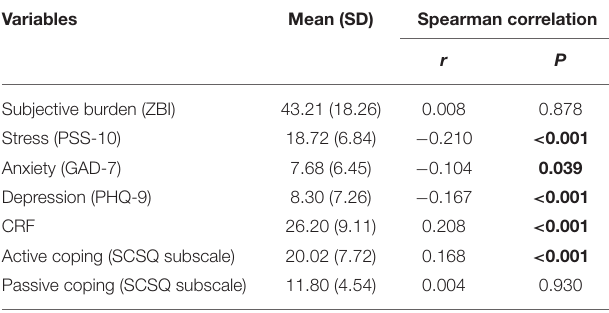
TABLE 2 | Caregiving impacts and Spearman correlation coefficients between outcomes and KSCS